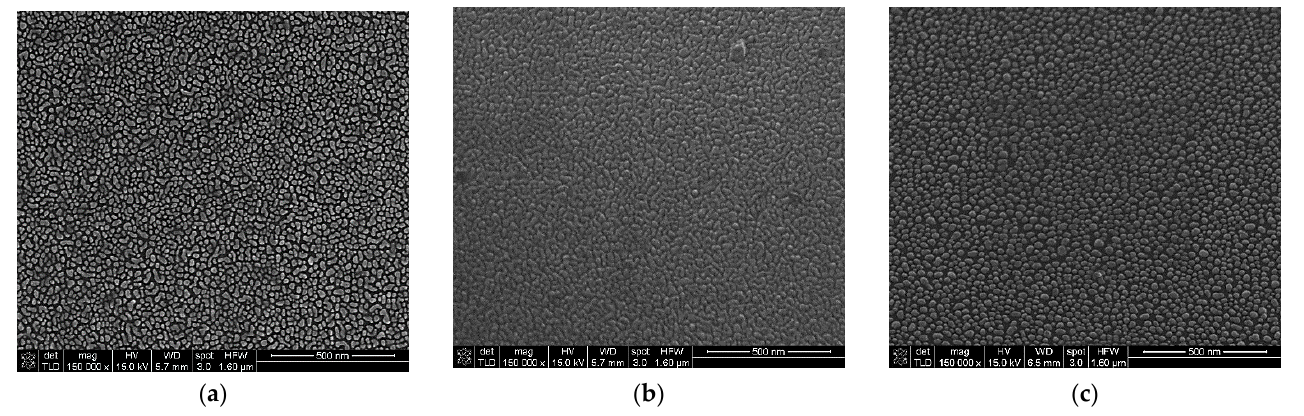
Figure 7. SEM micrographs of a 4 nm metallic (mass equivalent): ( a ) — Au, ( b ) — Al, ( c ) — Ag.